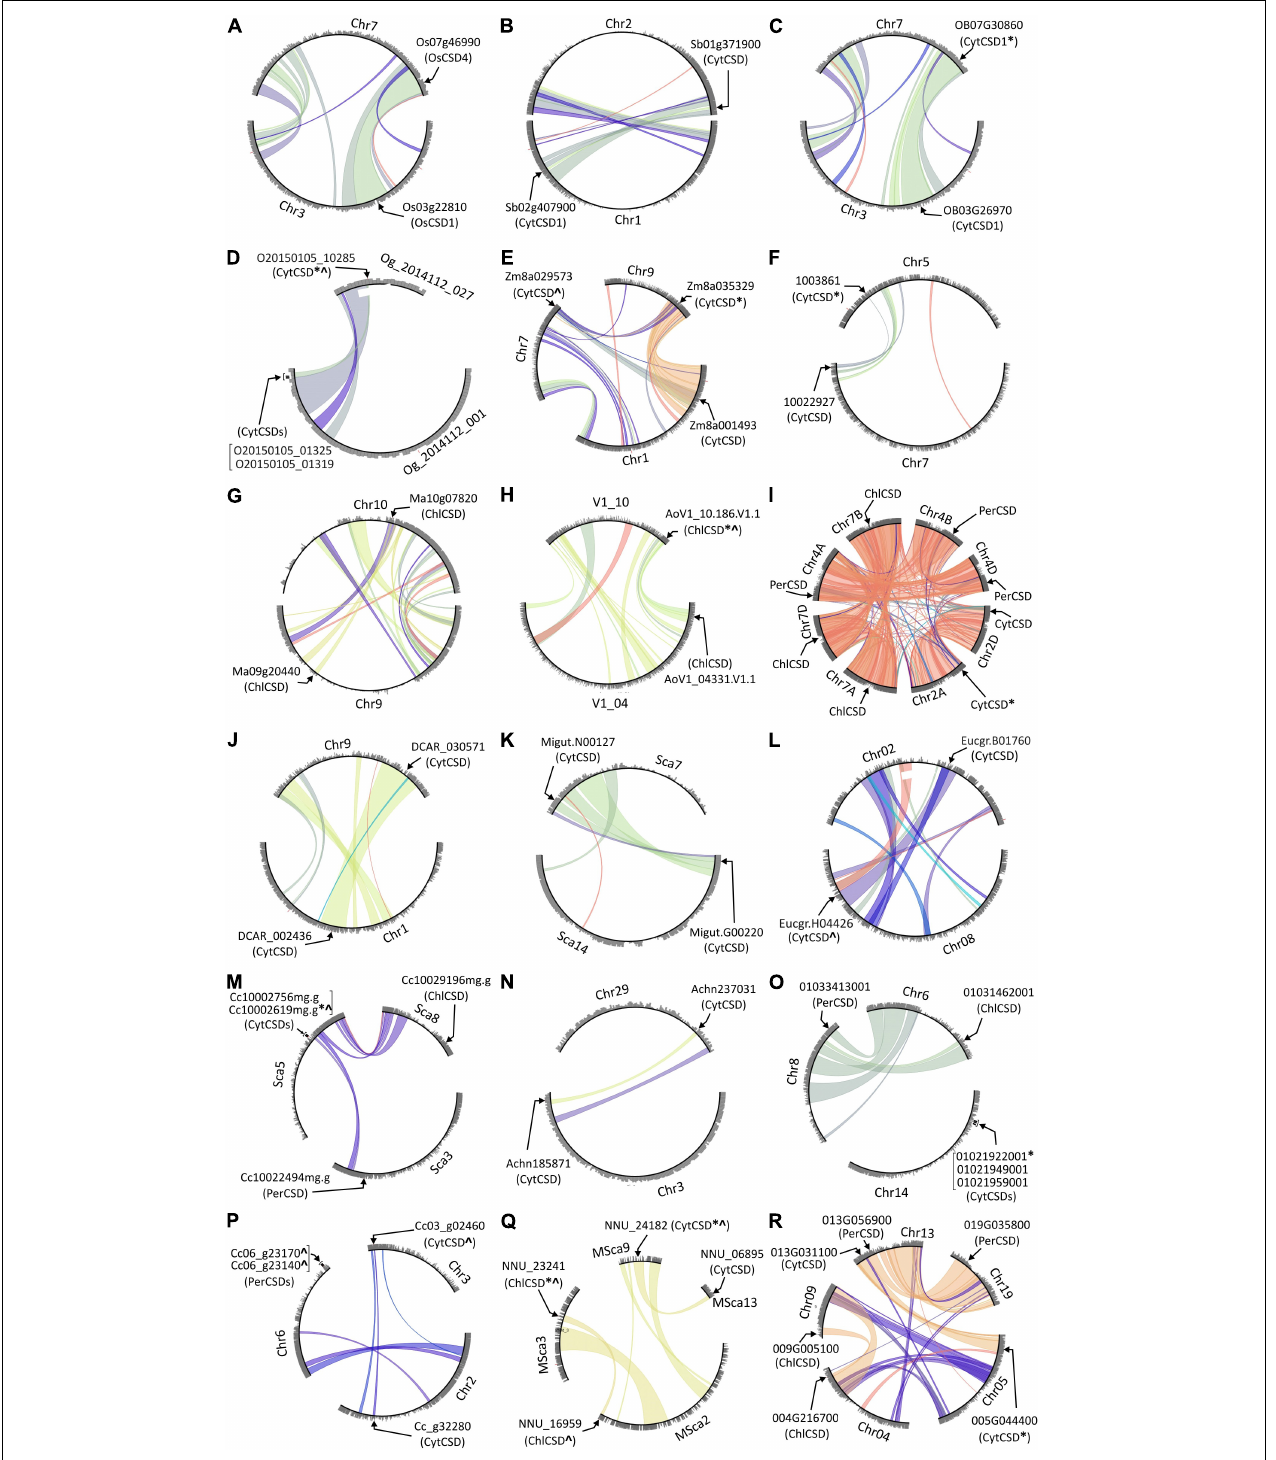
FIGURE 10 | Circle plots generated at PLAZA database showing tandem/block duplications of cytosolic (CytCSDs; OsCSD1, OsCSD4 in rice), chloroplastic (ChlCSD), and peroxisomal (PerCSDs) CSD isoforms among some monocots [ (A) O. sativa , (B) S. bicolor , (C) O. brachyantha , (D) O. thomaeum , (E) Z. mays (PH207), (F) C. americanus , (G) M. acuminata , (H) A. officinalis , and (I) T. aestivum ] and dicots [ (J) D. carota , (K) E . guttata , (L) E. grandis , (M) C. clementina , (N) A. chinensis , (O) V. vinifera , (P) C. canephora , (Q) N. nucifera , and (R) P. trichocarpa ]. In general, the chromosomes involved in block/tandem are shown with designations (Chr, chromosome; LG, linkage group; Sca, scaffold, etc.) and gene ids as per the PLAZA database. The arrows indicate the location of CSDs, “*” indicate copies with variations in SOD domain/important features, and “ˆ” indicate copies containing variation due to indels.